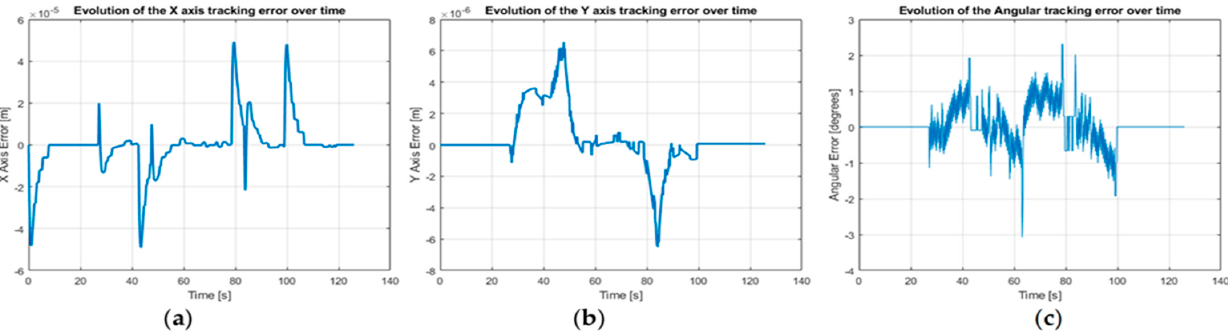
Figure 24. ( a ) X axis and ( b ) Y axis tracking errors in absolute coordinates, ( c ) angular tracking error expressed in radians per second for ARS PeopleBot.